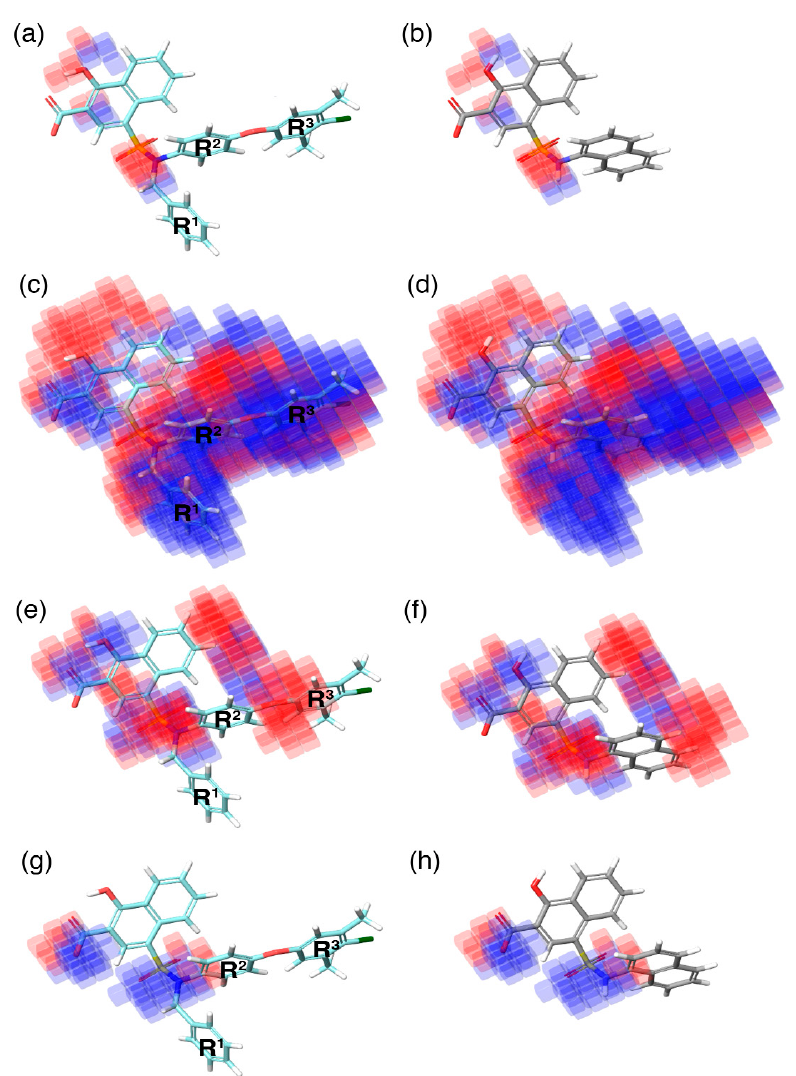
Figure 5. The highly active ( C40 –cyan), and inactive ( C1 –gray) molecules superposed over the 3D- QSAR model, represented in semi-transparent cubes (blue—positive regression coefficient; red— negative regression coefficient) in the context of ( a , b ) H-bond donor, ( c , d ) hydrophobic, ( e , f ) negative- ionic, and ( g , h ) electron-withdrawal effects, respectively. R 1 , R 2 , and R 3 on the highly active compound represent the regions substituted to improve the activity of the compounds.